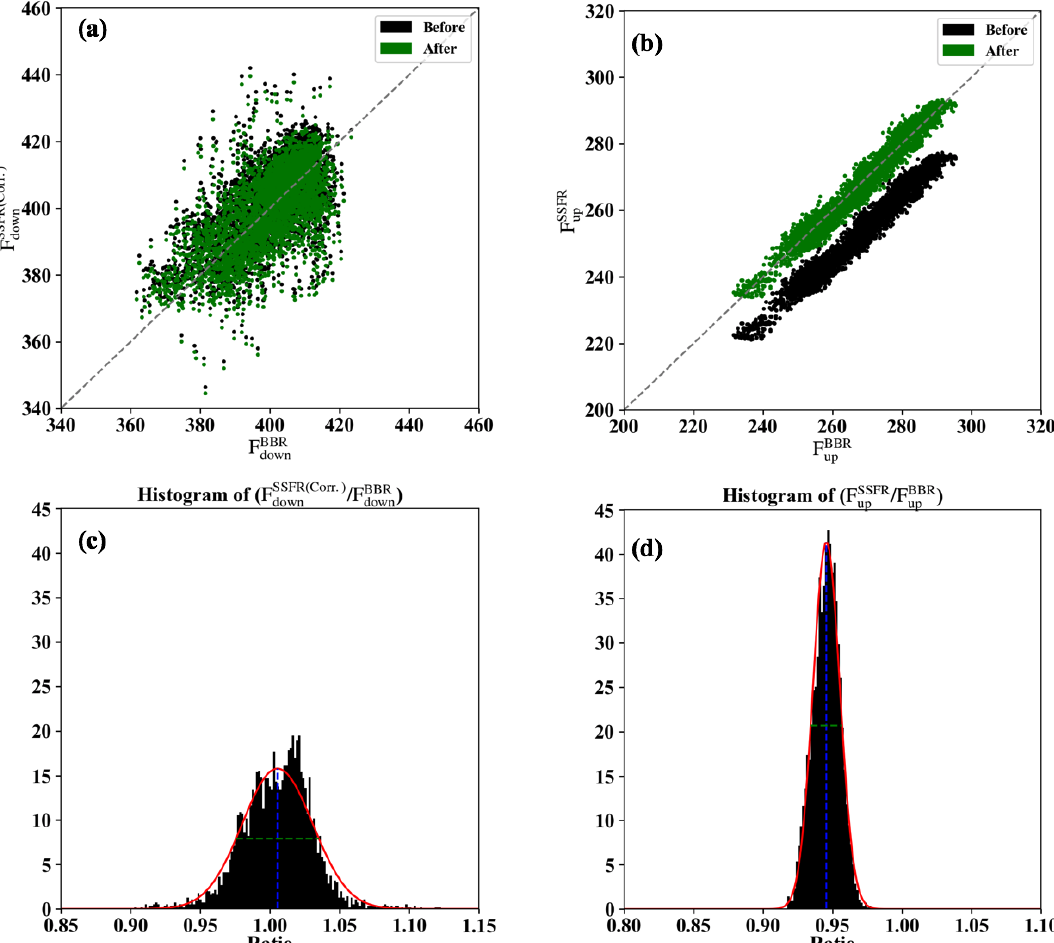
Figure D1. SSFR integrated broadband irradiance versus BBR broadband irradiance ( a : downwelling; b : upwelling) and the histograms of the ratio of SSFR integrated broadband irradiance to BBR broadband irradiance ( c and d ) for the 0911-above-cloud case. The mean and the full width at half maximum of the Gaussian distribution of the ratio are indicated as blue and green dashed lines in the histogram plots. The SSFR–BBR data (SSFR after applying the scale factor as indicated by the blue dashed line) versus BBR is indicated in green in (a) and (b)